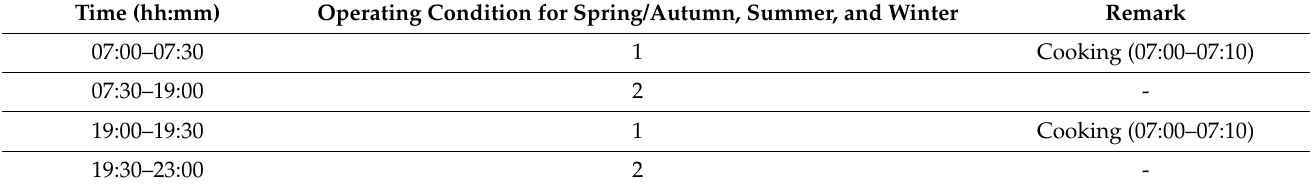
Timetable of IAQ management operating conditions for the general energy consumption